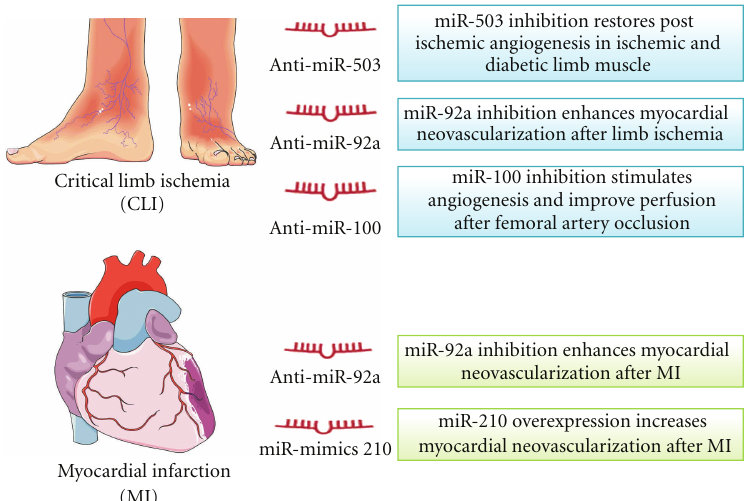
Figure 1: miRNAs-based therapeutic strategies in vascular repairs, There are two major approaches to developing miRNA-based therapeutics: miRNA antagonists and miRNA mimics. miRNA antagonists are generated to inhibit endogenous miRNAs that show a pathogenic gain-of-function in diseased tissues. miRNA mimics are used to upregulate expression of beneficial miRNAs. Inhibition of miR- 92a, miR-100 and miR-503 or increase of miR-210 can promote angiogenesis, thus improving postischemic blood flow recovery in limb ischemia or myocardial